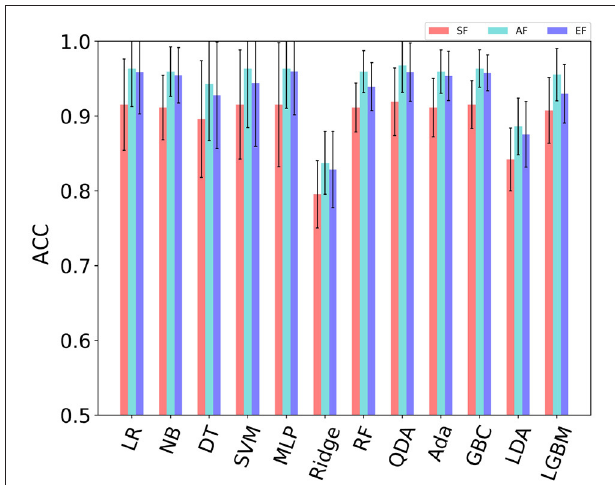
FIGURE 10 | Comparison of the average accuracy of all subjects in different combinations of features. The result is the average of all subjects, and the standard deviation is indicated in the figure. SF: The maximum accuracy rate of each model are selected first across different single-feature (SF) for per single subject, and then the average value of the selected maximum is calculated across all subjects. AF: Performance when using all features. EF: Elected features, here are RMS, MAC, and